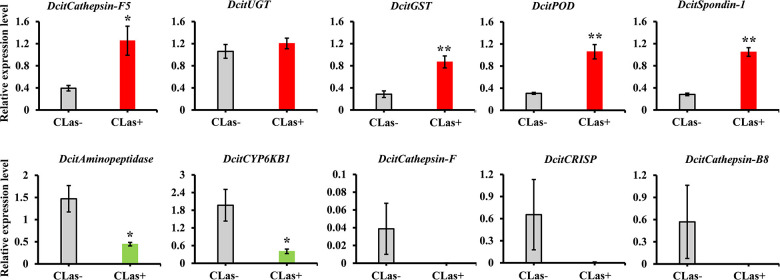
The expression analysis of 10 DEGs to validate the RNA-Seq data by RT-qPCR. Relative expression levels were normalized to the reference genes GAPDH2 and Actin1 expression levels using the 2– ΔΔCt method. The vertical bars represent standard errors (SE) of the mean (n = 4) and asterisks represent the significant difference (*P < 0.05 or **P < 0.01) using independent t-test.